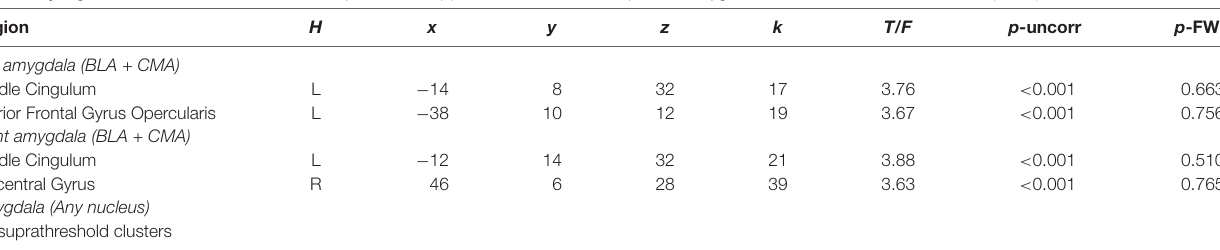
TABLE 3 | Significant clusters associated with experiential reappraisal success with respective amygdala seeds restricted to PFC mask (aim 2). Region H